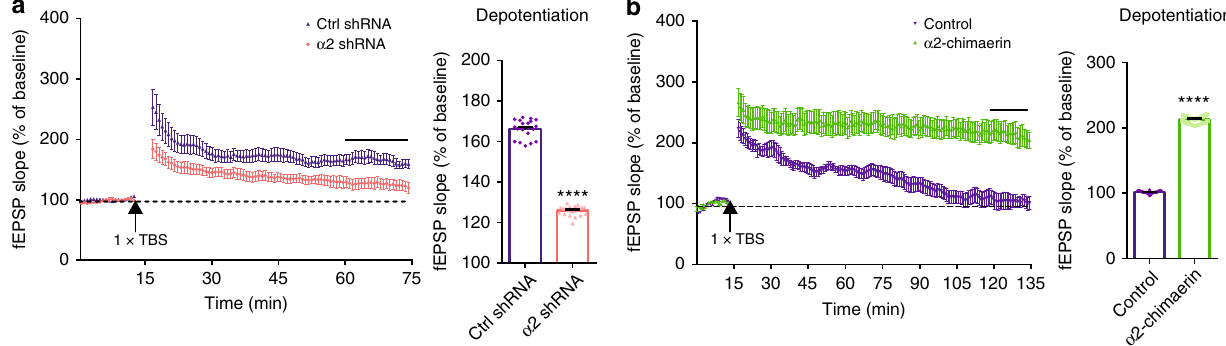
Fig. 6 α 2-chimaerin knockdown and overexpression modulate the stability of LTP. a , b LTP in slices from α 2 sh mice and α 2 mice, as well as their controls (ctrl sh or ctrl, respectively) (left), and the average fEPSP slope in the last 15 min of the LTP recording (right). One theta burst stimulation was given 15 min after baseline recording and LTP was recorded in the Schaffer collateral pathway for 1 h ( a ) or 2 h ( b ). **** P < 0.0001 (from unpaired t -test); n = 8, 9 mice ( a ), n = 11, 8 mice ( b ). Data are presented as means ± SEM. Also see Supplementary Table